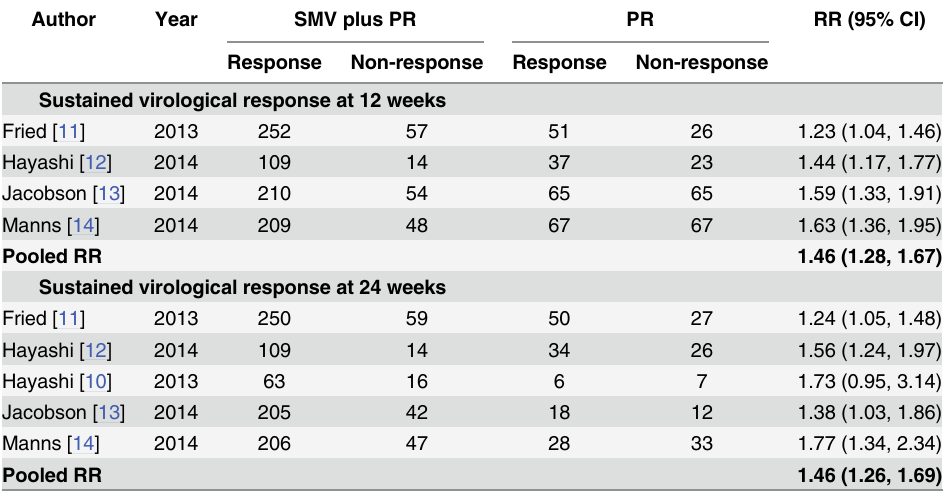
CI, con fi dence interval; PR, pegylated interferon-ribavirin; RR, risk ratio; SMV,